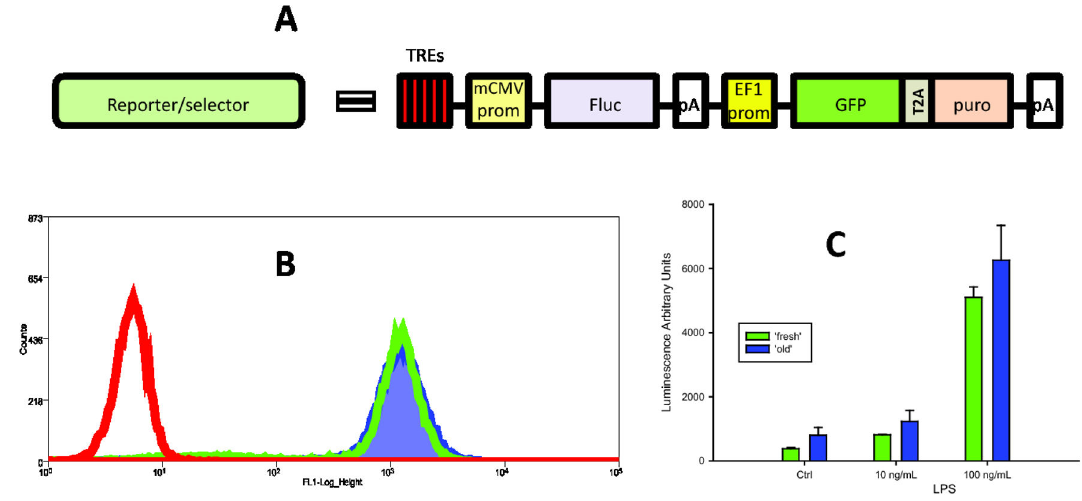
Figure 3. Stable transfection of monocytic THP-1 with pB-based, insulated NF-κB reporter vector pTR01F. ( A ) Schematic representation of the pathway reporter (See also Figure S4) transposon, insulated as in construct H (Fig 1A). ( B ) FACS analysis of GFP expression in THP-1 (non-fluorescent control, red diagram), the transfect THP.R01F freshly thawed from a cryopreservation (green), and THP.R01F that was cultured continuously for 10 months without any selection (blue). ( C ) Relative activity of NF-κB reporter in ‘fresh’ and ‘old’ THP.R01F batches in response to LPS